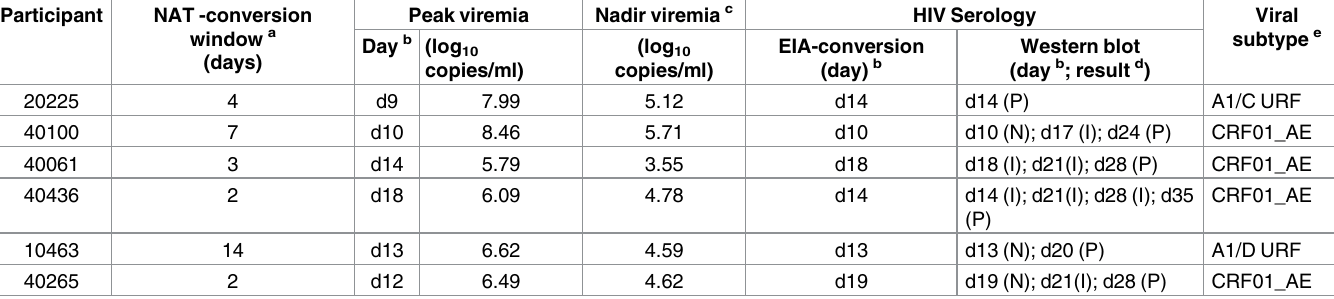
Table 2. Clinical characteristics of 6 participants from the acute HIV-1 infection cohort RV217.